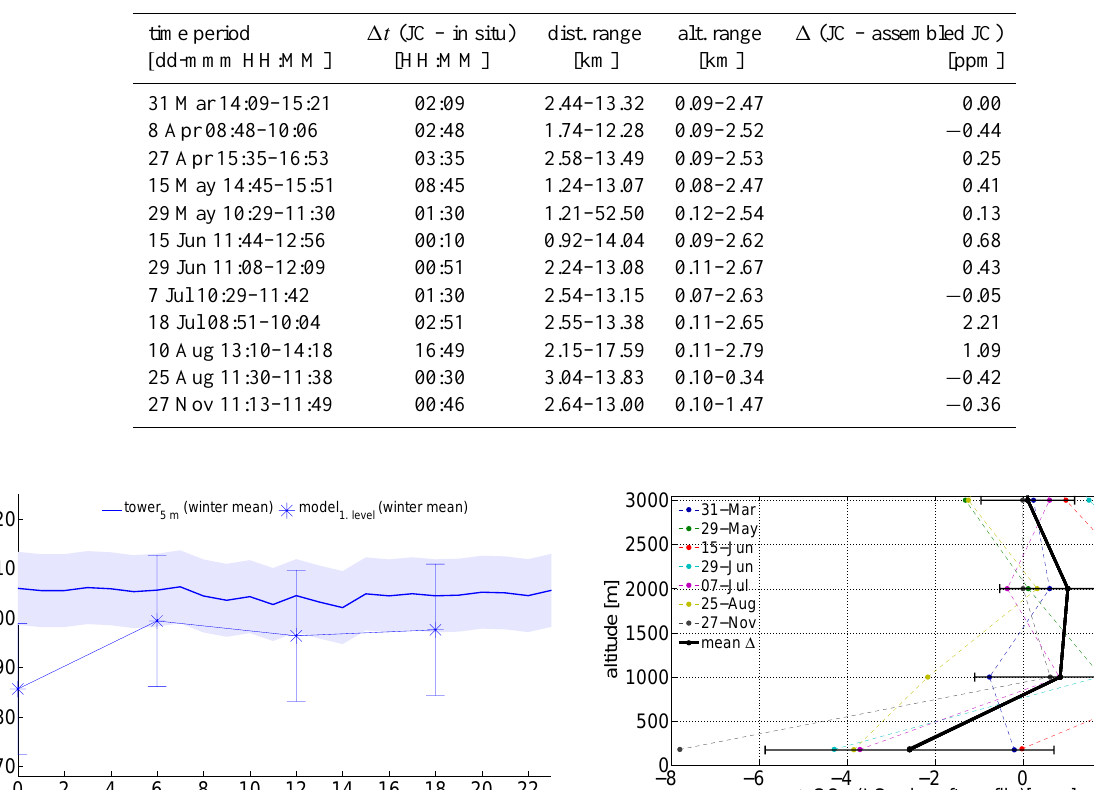
Table 2. Low aircraft overpasses available for the analyzed time period at the Białystok site. The date, the time difference to nearest available model output, the distance and altitude range are listed. The last column shows the difference between the integrated extended low aircraft profiles and the integrated most contemporary model result.